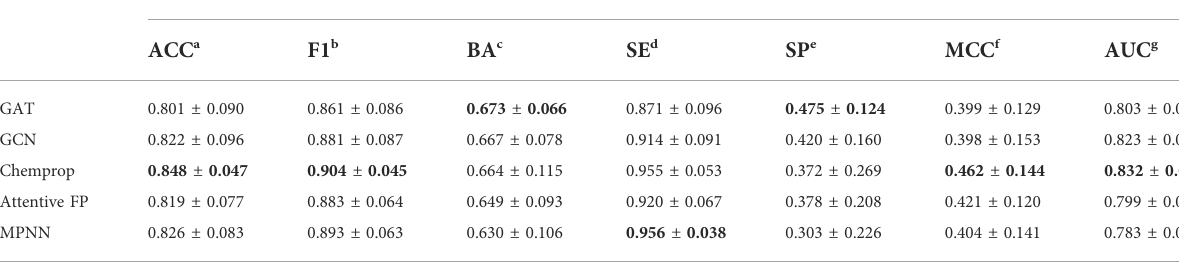
TABLE 3 The overall predictive performance of graph-based DL models for the test sets (sorted by BA value).